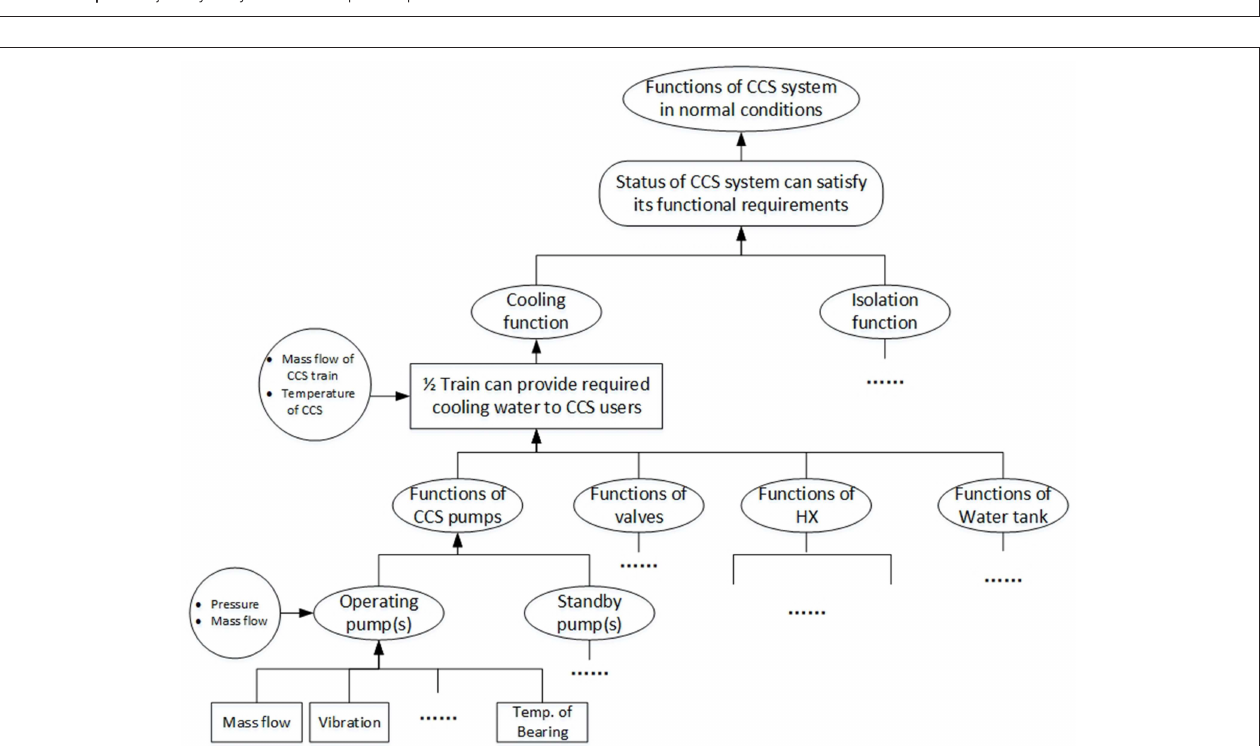
FIGURE 2 | Characteristic parameters of CCS